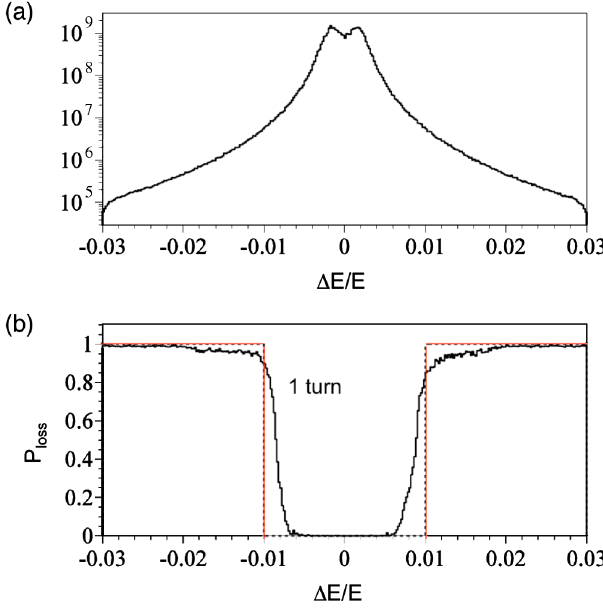
FIG. 6. SuperB low energy ring case: (a) Touschek probabil- ity density function as a function of energy deviation, i.e., generated Touschek particles per second all over the ring. (b) Comparison between the probability of particle loss due to Touschek scattering versus their energy deviation resulting from Bruck’s formula assuming an energy acceptance of 1% and from STAR